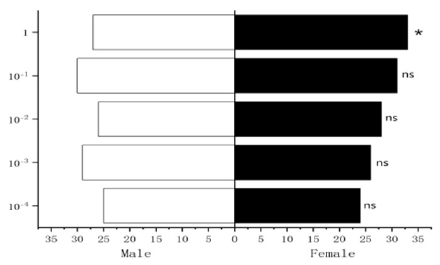
Figure 34. Comparison of behavioral responses of W. magnifica to 1-octen-3-ol.